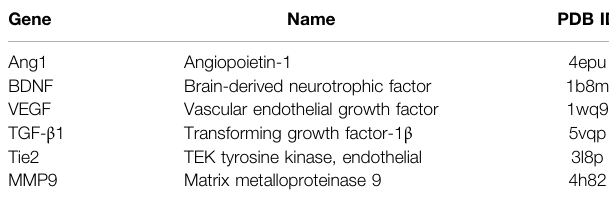
TABLE 5 | The information of target